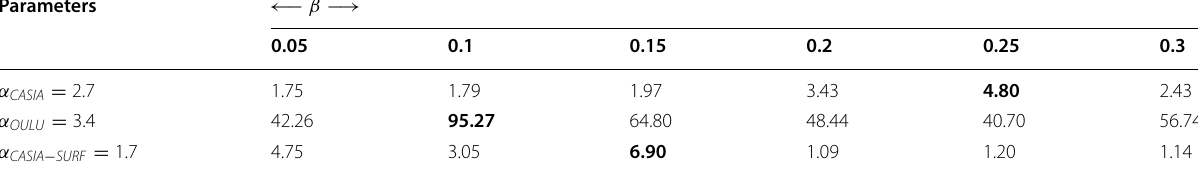
Table 2 Separation scores for all three datasets: CASIA, OULU, and CASIA-SURF Parameters